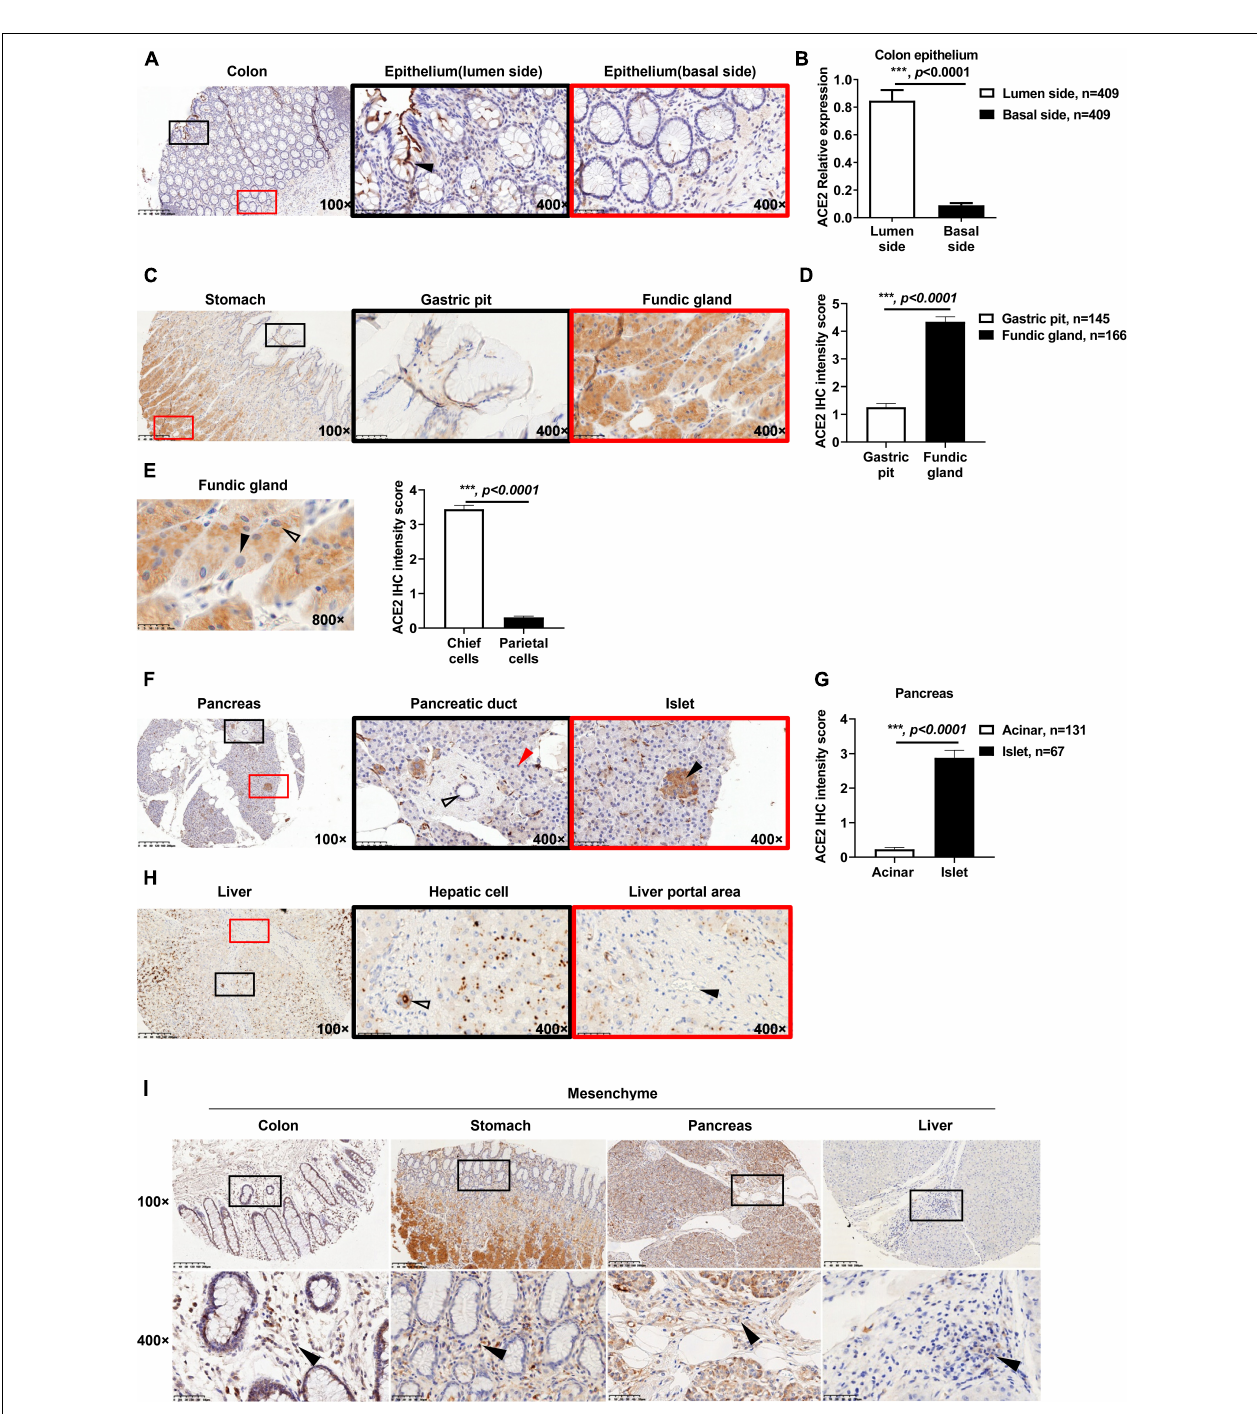
FIGURE 1 | Expression patterns of ACE2 in gastrointestinal tissues. (A) Representative immunohistochemical (IHC) staining of human colon sections with anti-ACE2 antibody. The black and red boxes are the indicated 400 × fields in the 100 × sections (black arrow: goblet cell). (B) Comparison of the ACE2 IHC intensity score between the basal side and lumen side of the colon epithelium. (C) Representative IHC staining of human stomach sections with the anti-ACE2 antibody. (D) Comparison of ACE2 expression between the gastric pit and fundic gland. (E) ACE2 expression in chief cells was higher (hollow arrow) than that in parietal cells (black arrow). Four chief cells and four parietal cells were analyzed per sample (50 samples). (F) Representative IHC staining of ACE2 protein in the pancreas, acinar cells (red arrow), pancreatic duct (hollow arrow), and pancreatic islet (black arrow). (G) Comparison of ACE2 IHC intensity between pancreatic acinar cells and pancreatic islets. (H) Representative IHC staining of human liver sections with the anti-ACE2 antibody. Interlobular duct (hollow arrow) and interlobular vessel (black arrow). (I) Representative IHC staining of gastrointestinal tissues. The black boxes are the indicated 400 × fields in the 100 × sections, and the black arrow indicates mesenchymal cells. Scale bar, 200 µ m (100 × ) and 50 µ m (400 × ). Data are shown as the mean ± SEM (B,D) .